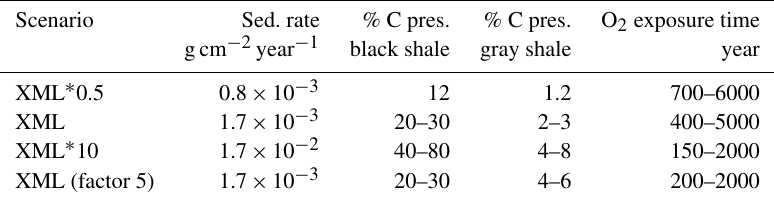
Table 2. Carbon preservation at various rates of sediment deposition. Scenario